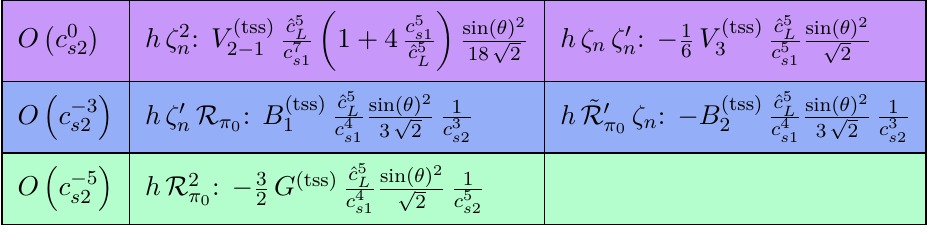
Table 5 . Squeezed f TSS for c s 2 (cid:28) 1 . We set V (tss)